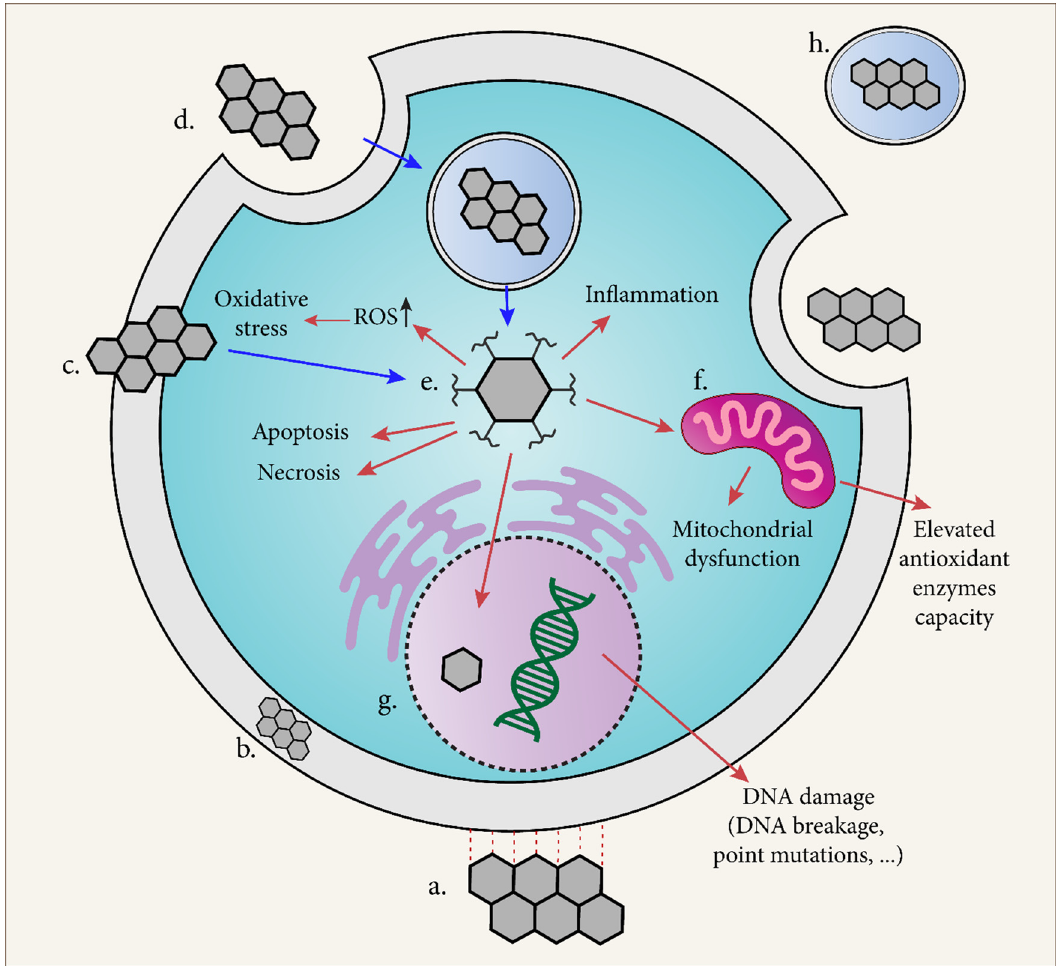
Figure 4: ( a ) Formation of hydrophobic bonds between graphene and the cell membrane; ( b ) localization of graphene between phospho - lipidic layers of the membrane; ( c ) cutting through the cell membrane with sharp graphene edges; ( d ) entering of graphene into cell plasma through the formation of endosomes; ( e ) internalization of graphene inside the plasma and induction of cytotoxicity via di ff erent pathways; ( f ) internalization of graphene inside mitochondria and inducing mitochondria - mediated toxicity; ( g ) internalization of graphene inside the nucleus and induction of genotoxicity; and ( h ) internalization of graphene inside